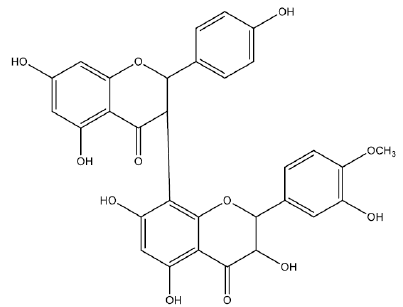
Figure 8. Biflavonoids (kolaviron) with gastroprotective and/or anti-ulcer activity.